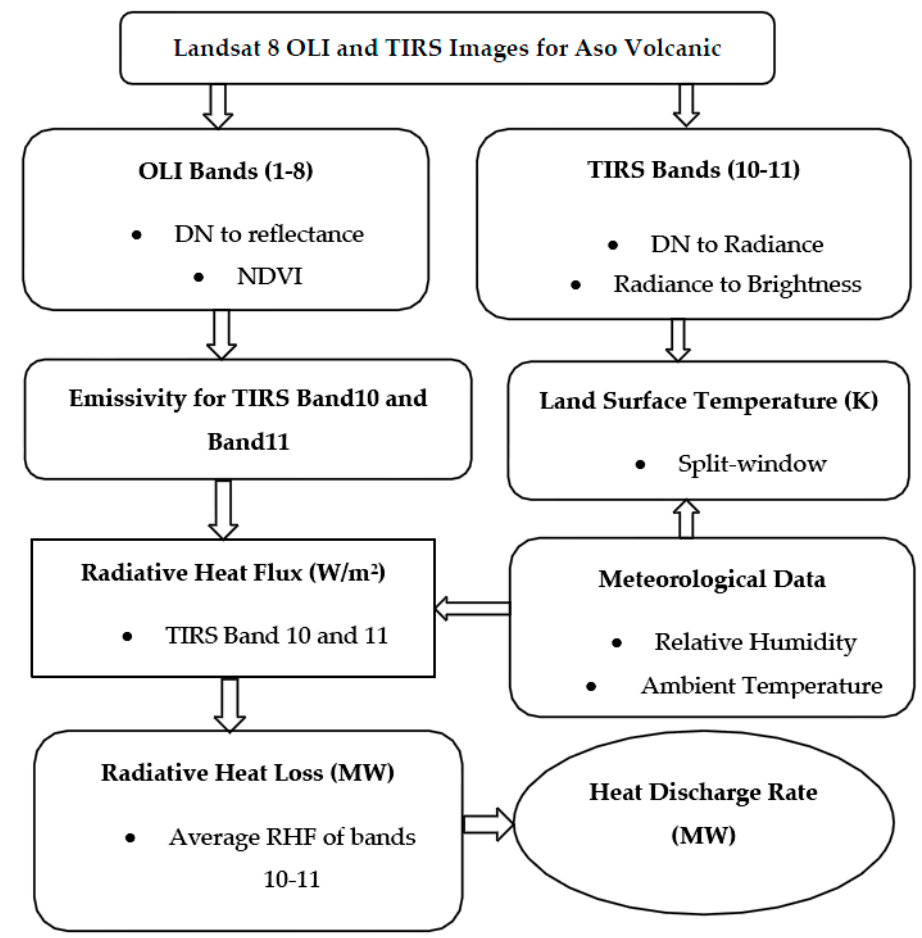
Figure 2. Flowchart showing the various steps of image processing in this study.